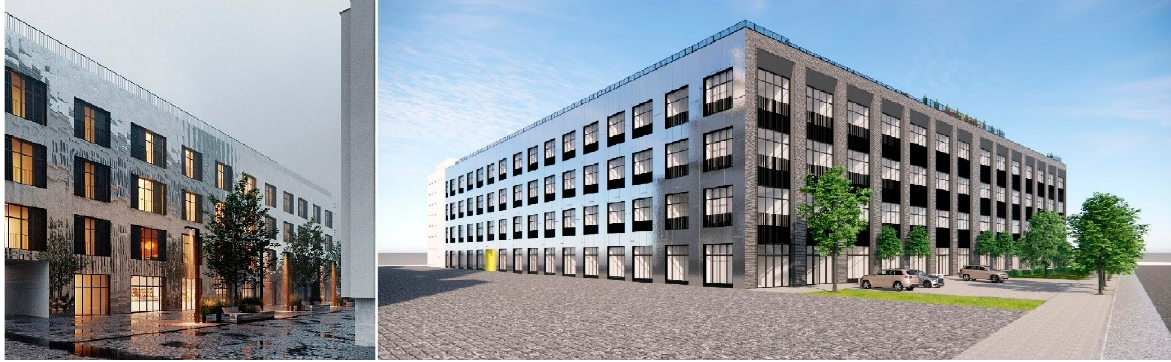
Figure 22. The facade of “Daina” (visualization courtesy of UAB Citus).